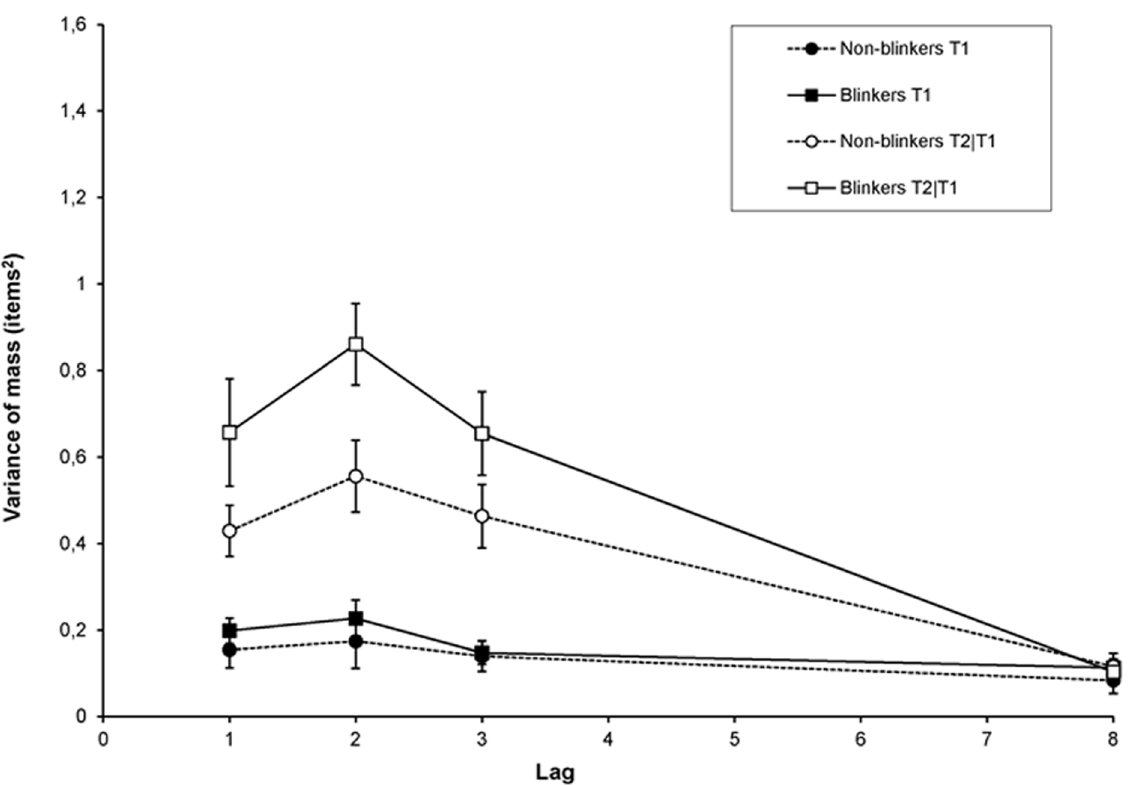
Figure 6. Diffusion in Experiment 1b. Diffusion of the temporal selection process expressed as the variance of the centre of mass in the selection window around T1 or T2 as a function of lag, for blinkers and non-blinkers.